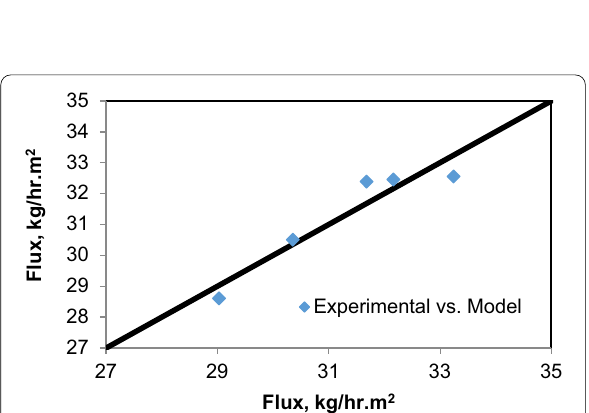
Fig. 2 Comparison between experimental data and model predicted water flux